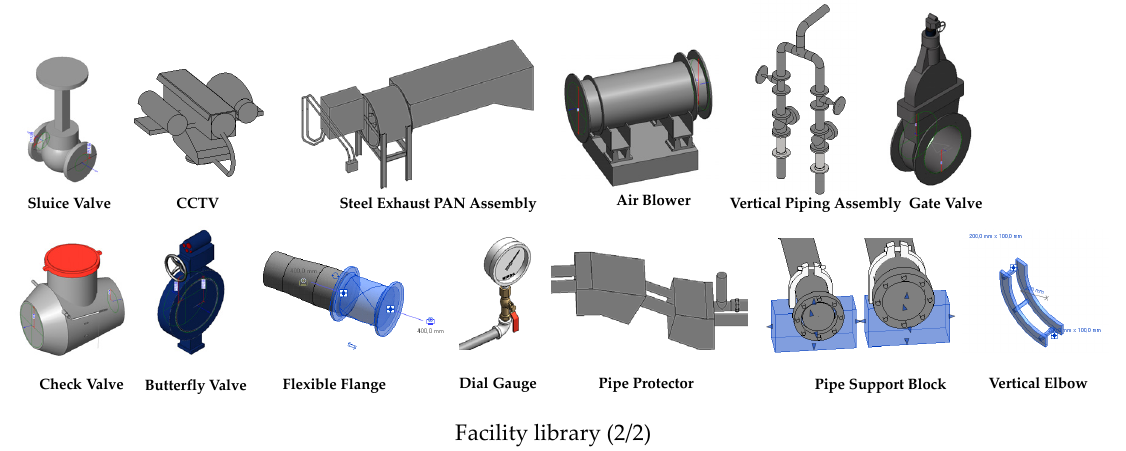
Figure 5. Underground utility tunnel BIM library.